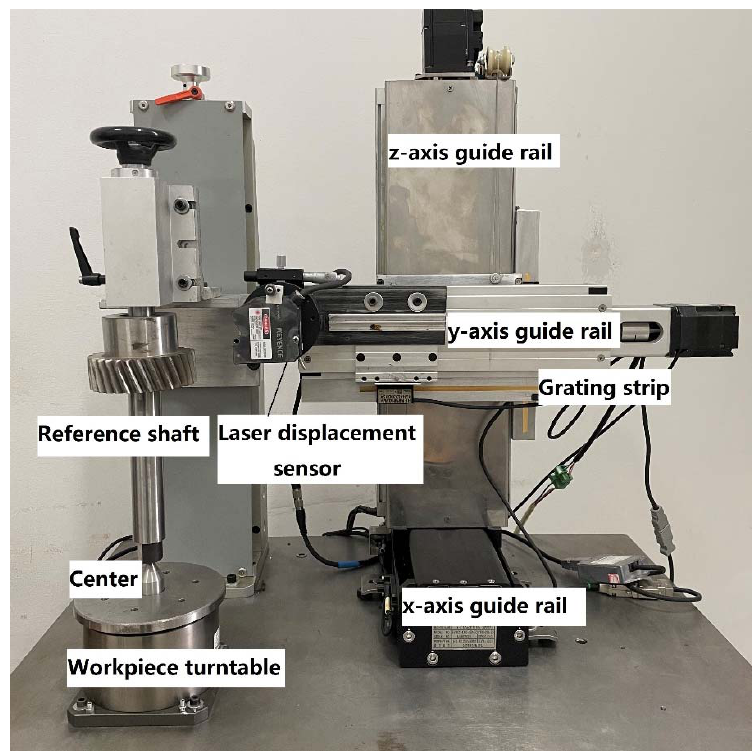
Figure 8. The measurement device.